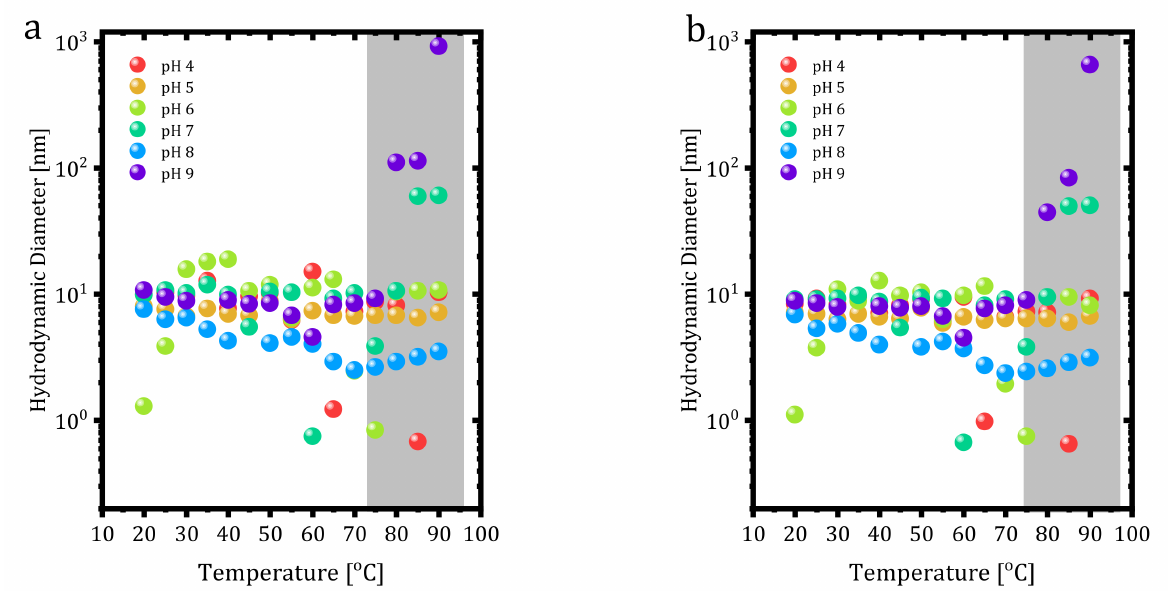
Figure 6. ( a ) Volume-based and ( b ) number-based temperature-ramped hydrodynamic diameter change of trastuzumab at different pH